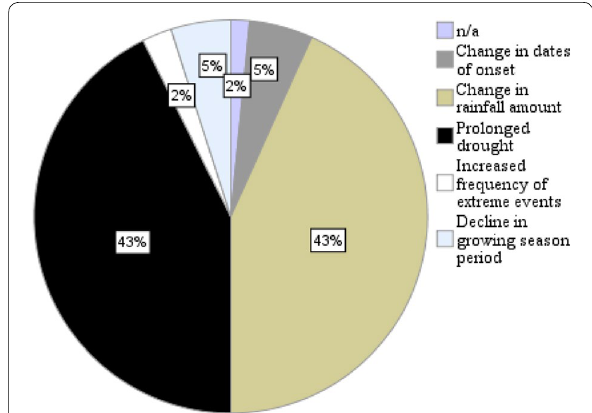
Fig. 2 Perceived evidence of climate change in Tharaka